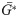
Signalling networks for neurite growth and gradient sensing.Activating (A) and inhibitory (I) signalling pathways are stimulated in parallel by NGF at the growth cone c1, and within the ganglion c2. By sensing an asymmetry in concentrations between growth cone and cell body, an extracellular gradient can be detected. (A) Model 1: growth. The signals are integrated by conversion of a substrate G to a growth promoting active form G*. (B) The steady-state output of the growth model, (G*¯, black line, normalised by maximum value) reproduces the biphasic ganglion outgrowth response in uniform concentrations (c1 = c2), and saturating dissociated cell response (c2 = 0, dotted line). Black squares are data replotted from Fig 1C, normalised by the maximum outgrowth at 0.3 nM. Due to these two constraints, the network lacks the sensitivity for gradient detection. The model response with a 50% asymmetry in inputs (c1 = 1.5c2, c2 defined by the x-axis; red line) shows only a small increase over the uniform condition. Parameters: k0 = 1, k1 = 100, k2 = 0.75 and KI = 5 nM. (C) Model 2: gradient detection. Signal integration occurs through intermediaries X and Y that convert a protein F to an active form F*. Dual negative regulation from an interaction between A and I yields a sensitive readout of the ratio c1/c2 in the steady-state output. (D) Gradient detection is robust to parameter perturbations for concentrations of 0.001 − 1 nM. For each pair (c1, c2), the average response over 100 trials with noisy parameters is shown. An output of F*¯=0.5 indicates the ‘decision’ that c1 = c2, F*¯>0.5 indicates c1 > c2, and F*¯<0.5 indicates c1 < c2. Parameters as described in Methods.